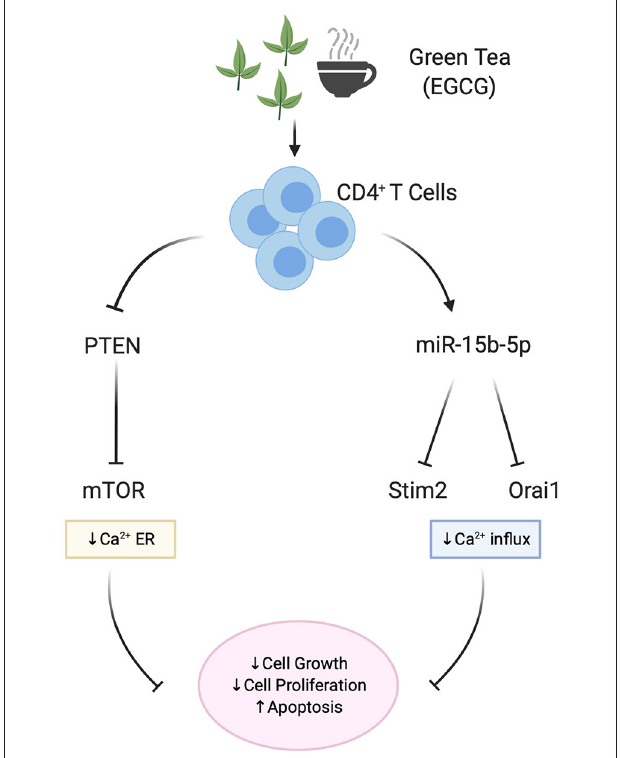
FIGURE 2 | Effect of EGCG on miRNA and Ca 2 + signaling in T cells. EGCG is able to upregulate miR-15b-5p, thus decreasing Calcium influx (SOCE) proteins Orai1/STIM2. As a result, Ca 2 + -sensitive functions of T cells such as cell proliferation and cell growth in mice CD4 + T cells are blunted. As shown in human Jurkat lymphoblasts, EGCG also downregulates the PTEN/mTOR pathway and mitochondrial potential in addition to the Calcium influx, thus affecting the cell growth and